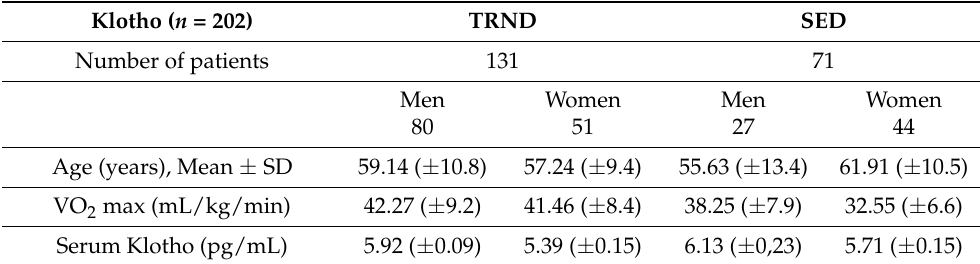
Table 1. Characteristics of subjects and VO2max, klotho levels. Klotho ( n = 202) TRND SED Number of patients 131 71 Men